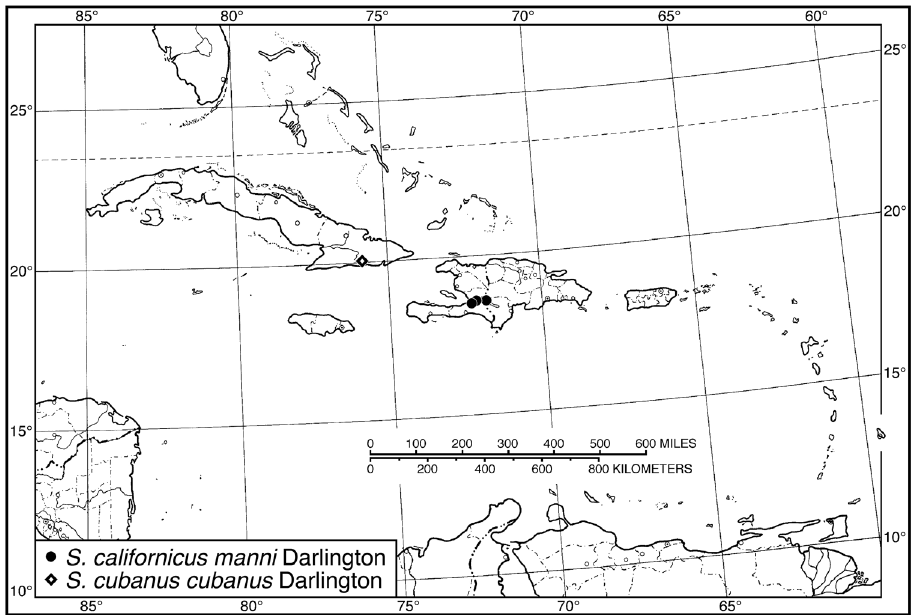
Figure 65. Map of West Indies showing known localities for species of Stenomorphus